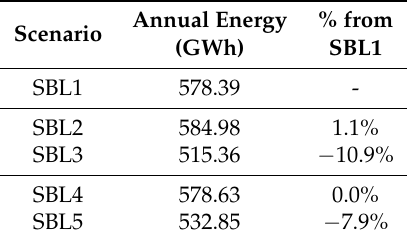
Table 5. Typical annual energy prediction extrapolated from a characteristic neap-spring tidal cycle for the five different